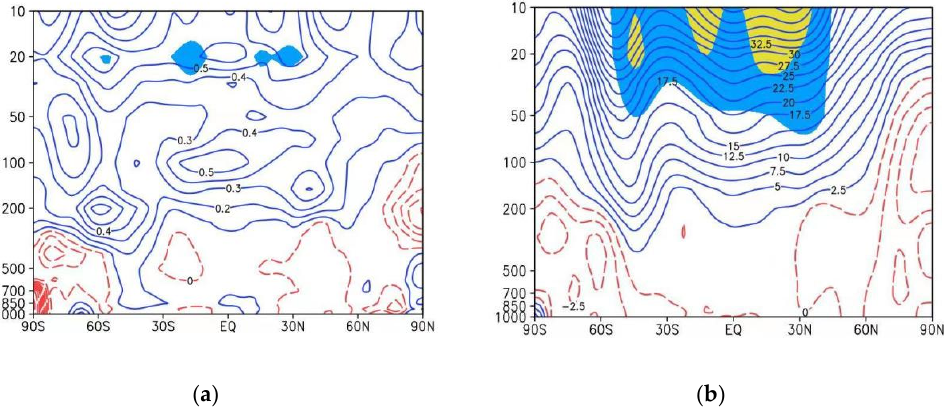
Figure 9. The composite mean difference (CMD) ‐ derived spatial patterns of ( a ) winter temperature and ( b ) winter geopotential height response to SRF. Shading indicates that the regions passed the 0.1 and 0.05 significance tests, respectively. (The solid blue line indicates the positive value, and the dot red line indicates the negative value. Units: latitude is °N, and longitude is °E).